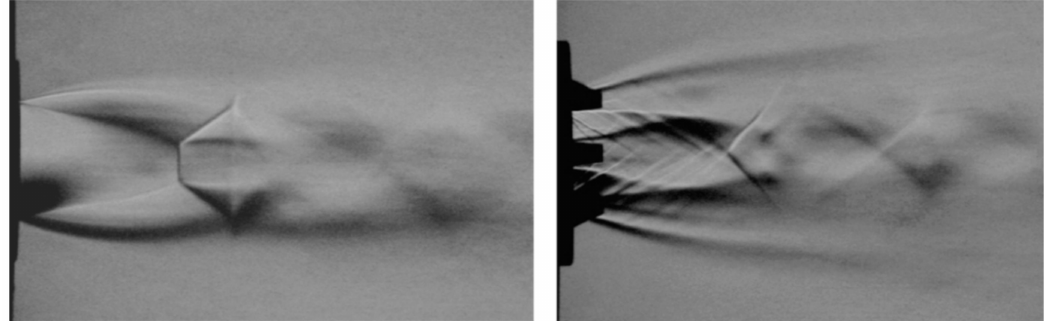
Figure 6. Flow structure in a supersonic underexpanded jet exhausting from a nozzle without a vortex generator ( left ) and from a nozzle with six chevrons applied at the nozzle exit ( right )